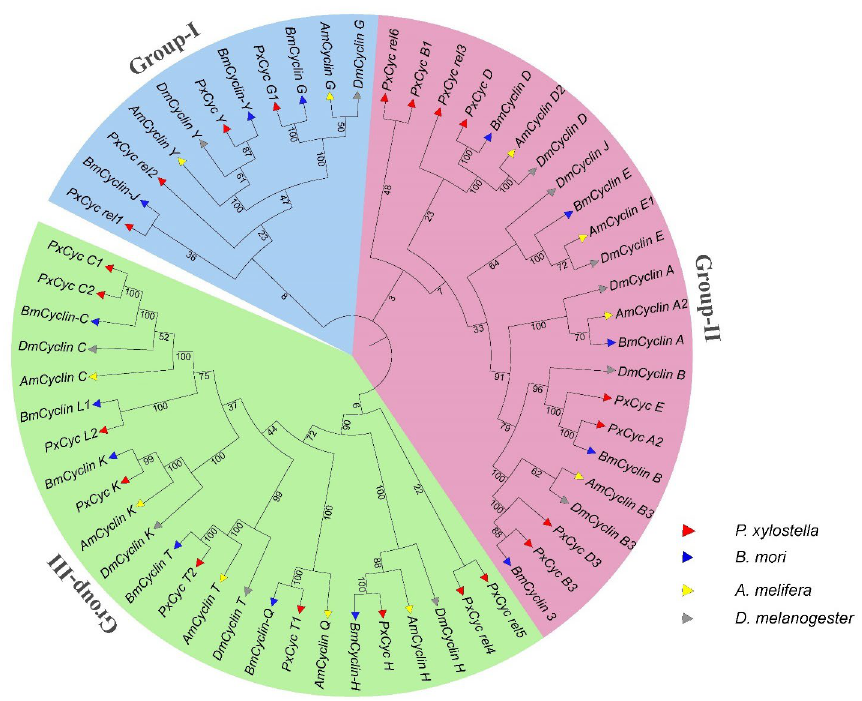
Biology 2022 , 11 , x FOR PEER REVIEW